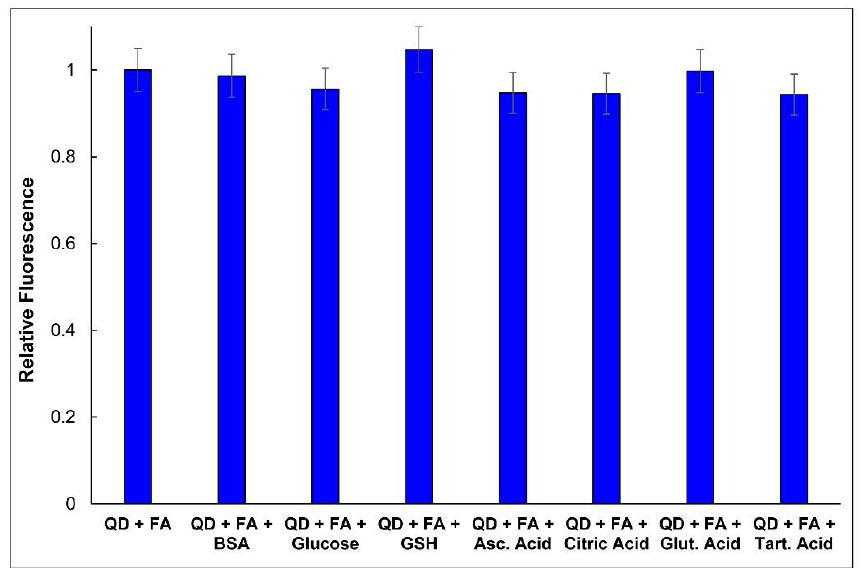
Figure 6. Results of the competition experiments in PBS buffer (pH = 8). Molar ratio of FA:Interference = 1:20.